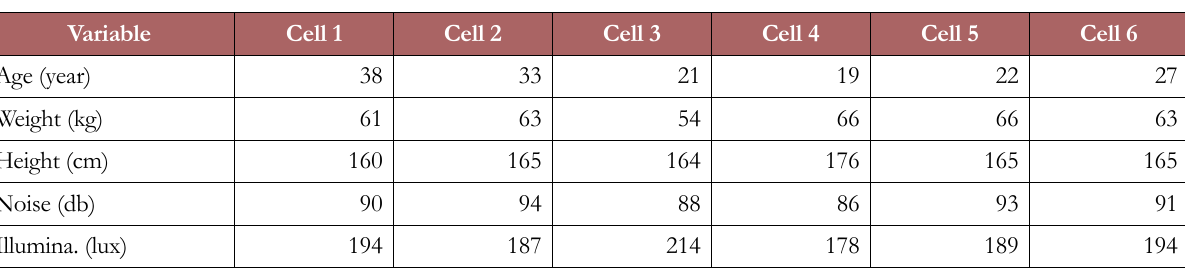
Table 2. Values of independent variables from the front of motorcycles